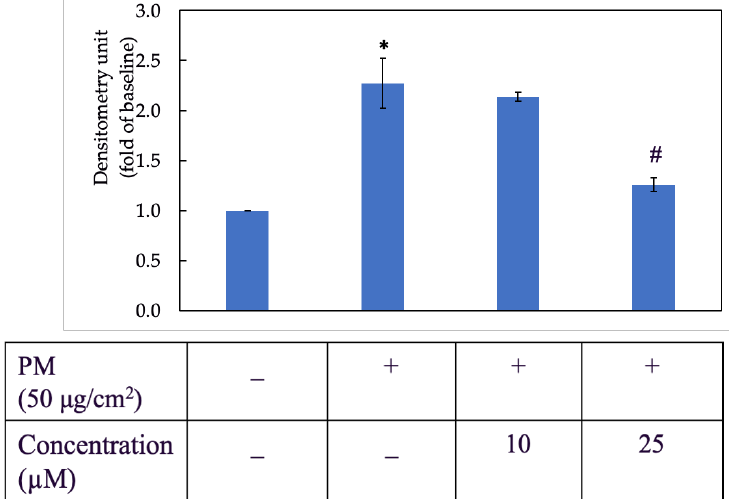
Figure 3. Effect of morin on PM-induced ROS generation in HaCaT keratinocytes. +, − mean with or without exposing to PM or morin, respectively. Data were presented as mean ± SD and from triplicate experiments. *, # indicates a statistically significant difference with control group (without treating PM and morin) and PM group (only treating PM), respectively, p < 0.05 .